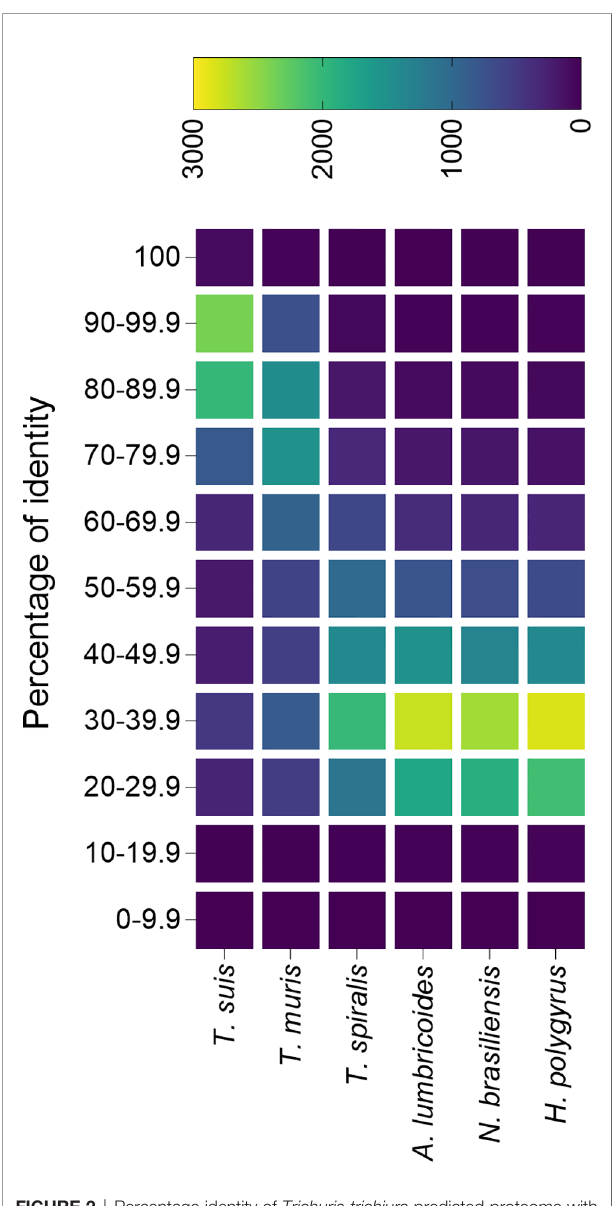
FIGURE 2 | Percentage identity of Trichuris trichiura predicted proteome with the predicted proteins from different nematode species. The predicted proteome from different species of trichurids and unrelated nematodes were compared against the predicted proteome from T. trichiura and plotted in a heatmap. All predicted proteomes were downloaded from Parasite WormBase (v.14.0) and protein identity was calculated using Blast. Colour represents the number of proteins within a range of identity